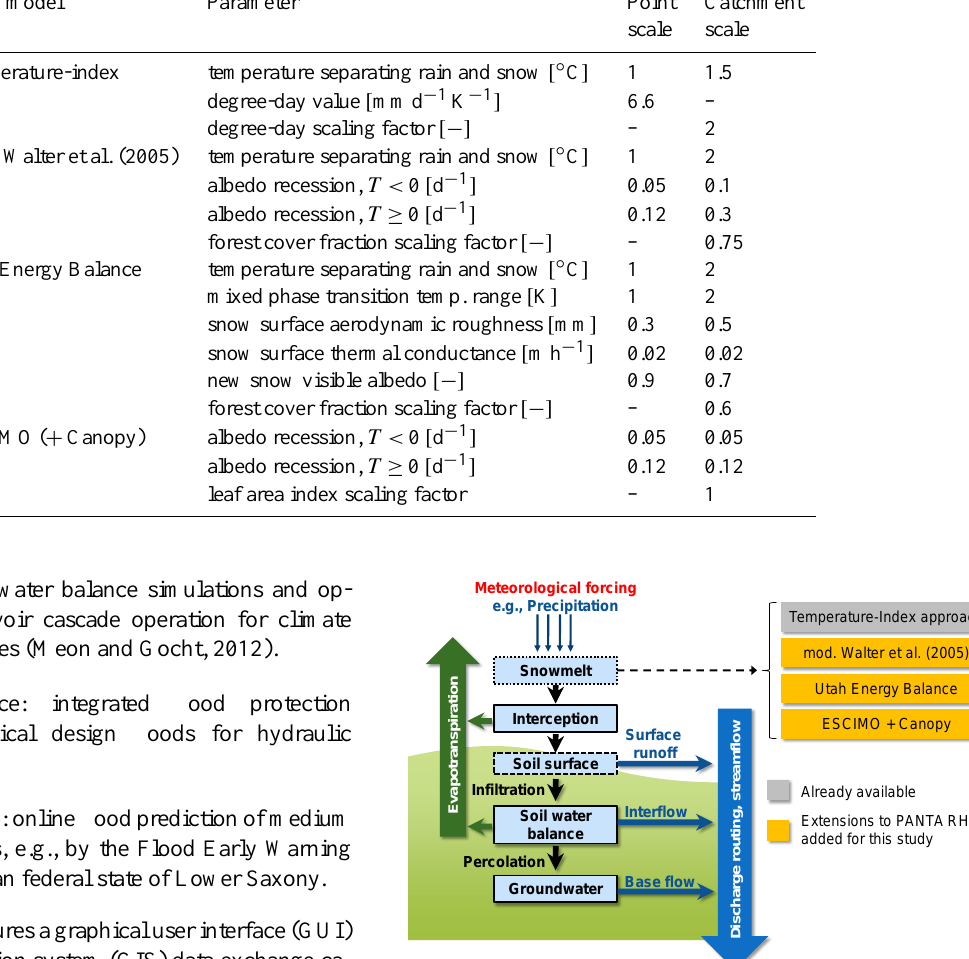
Table 2. Model parameters that were altered throughout the calibration process for both the point and the catchment scale. Please note that the catchment-scale parameters refer to the entire Sieber catchment upstream of the Pionierbrücke gauging station. Snow model